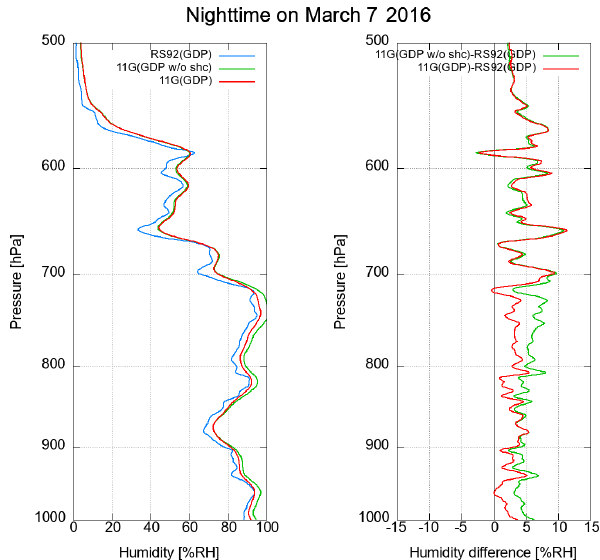
Figure 13. Profiles of relative humidity and differences (RS-11G GDP minus RS92 GDP). RS-11G (GDP) shows RS-11G GDP RH with SHC correction, and RS-11G (GDP w/o SHC) shows RS-11G GDP RH without SHC correction. RS92 data are not included in SHC checking at